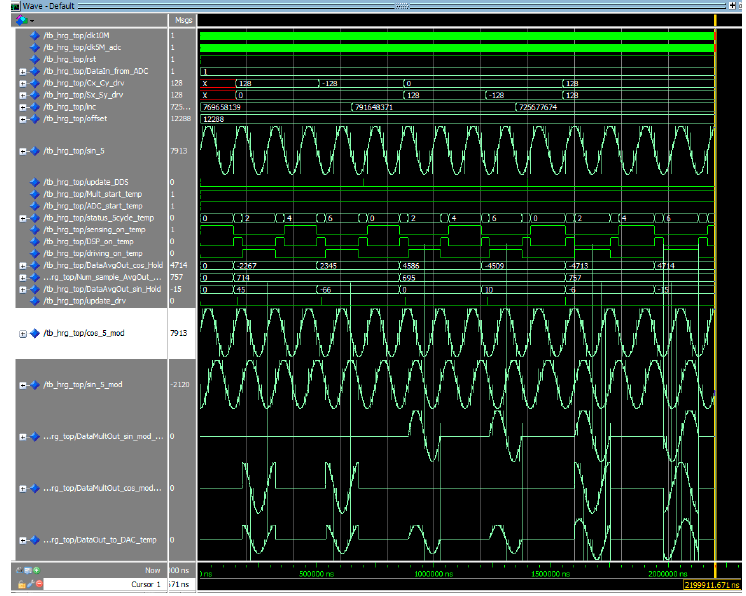
Figure 10. Total operation simulation result of the FPGA signal processing algorithm.